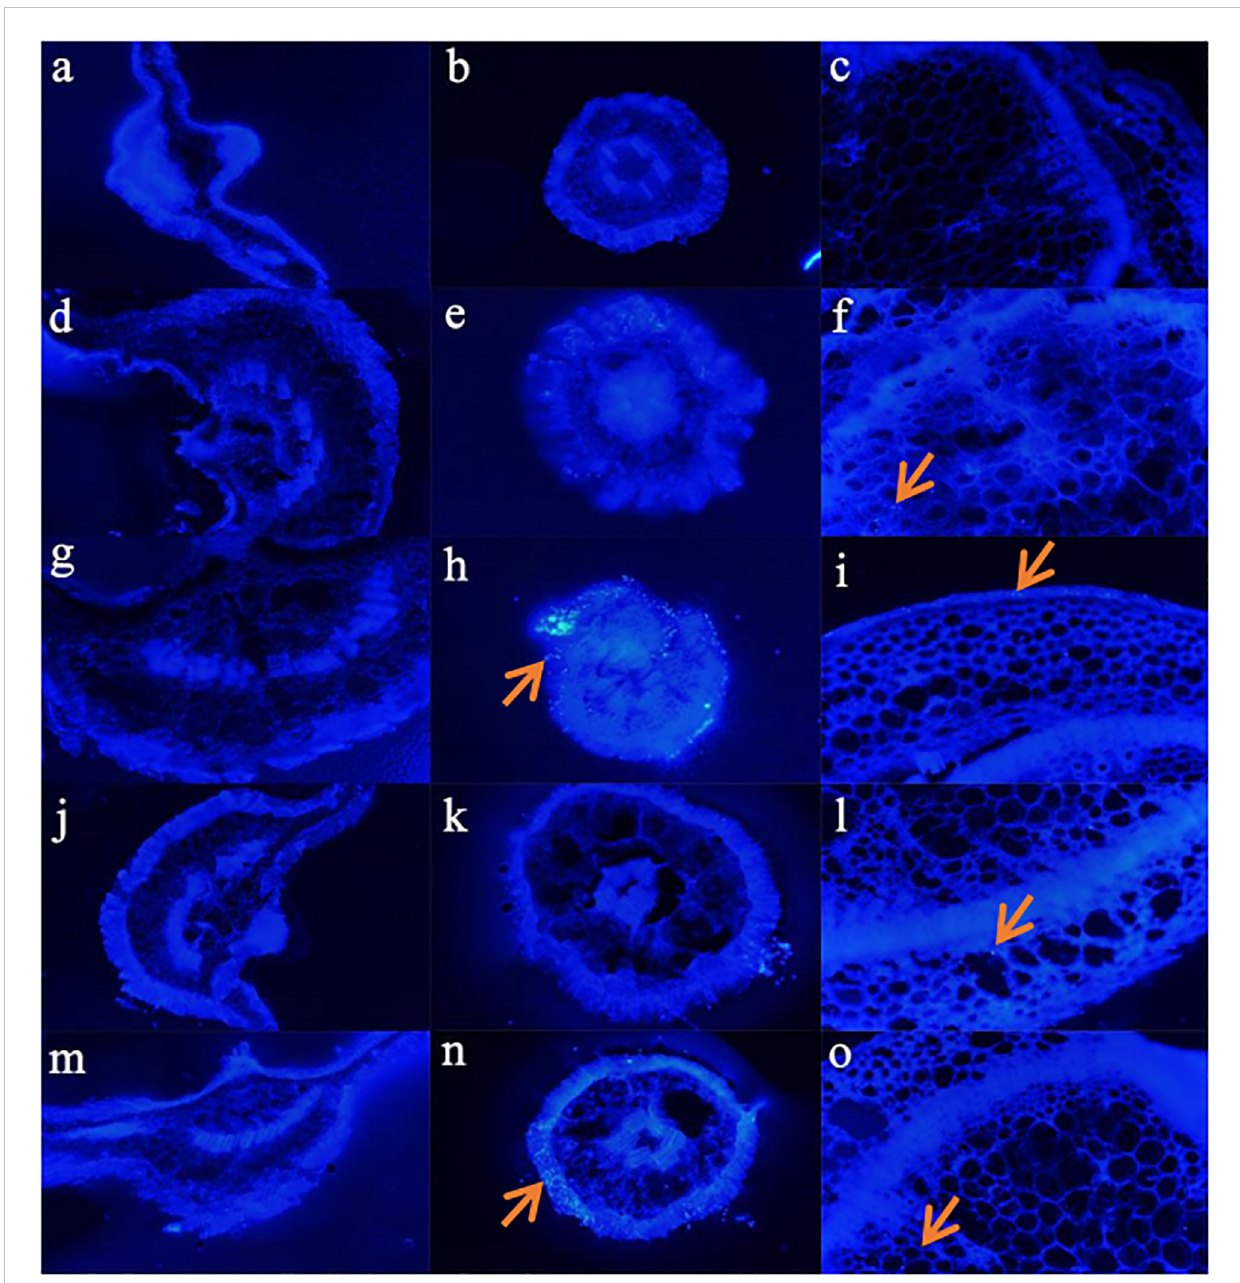
FIGURE 6 Distribution of PE fl uorescent MP spheres in transverse sections of leaves (A) : Control, (D) : 1% PE MPs, (G) : 3% PE MPs, (J) : 1% PE MPs + Cd, (M) : 3% PE MPs + Cd), roots (B) : Control, (E) : 1% PE MPs, (H) : 3% PE MPs, (K) : 1% PE MPs + Cd, (N) : 3% PE MPs + Cd) and stems (C) : Control, (F) : 1% PE MPs, (I) : 3% PE MPs, (L) : 1% PE MPs + Cd, (O) : 3% PE MPs + Cd) of sweet potatoes. Sweet potatoes are treated with 5 m m of monodisperse blue fl uorescent PE MPs and Cd for 7 days and are checked using a biological fl uorescence microscope. The positions of the PE MPs are marked with red